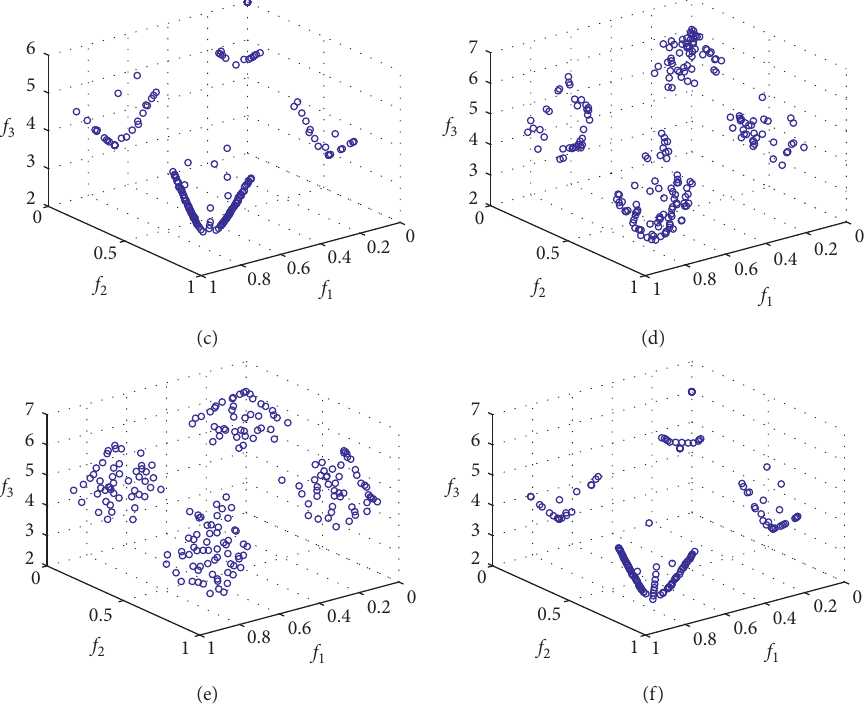
Figure 4: The approximate front of FMOESA, MOEA/D, dMOPSO, NSGAII, MOEA/D-STM, and MOEA/D-ACD on DTLZ7. (a) FMOESA, (b) MOEA/D, (c) dMOPSO, (d) NSGAII, (e) MOEA/D-STM, and (f)